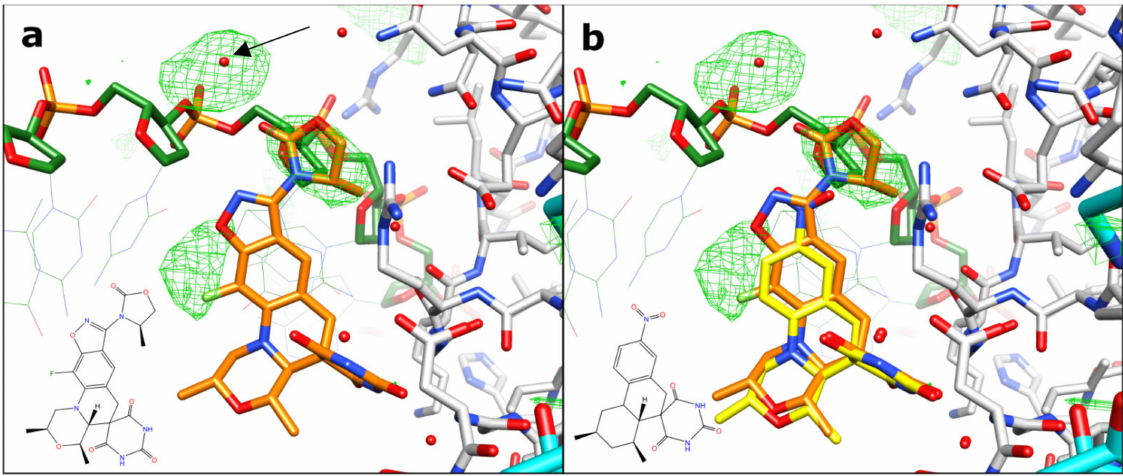
Figure 6. Difference in map densities from refined QPT-1 structure against zoliflodacin data . ( a ) The F o -F c map from refined QPT-1 coordinates contoured at 3 σ shows extra features in the zoliflodacin structure not in the QPT-1 starting coordinates. The arrow points to extra density modelled as water, which could be a metal ion (it is close to the oxygen of a phosphate from the DNA backbone and also an oxygen from methyl-oxazolidine-2-one). ( b ) Refined QPT-1 coordinates are also shown with yellow carbons.